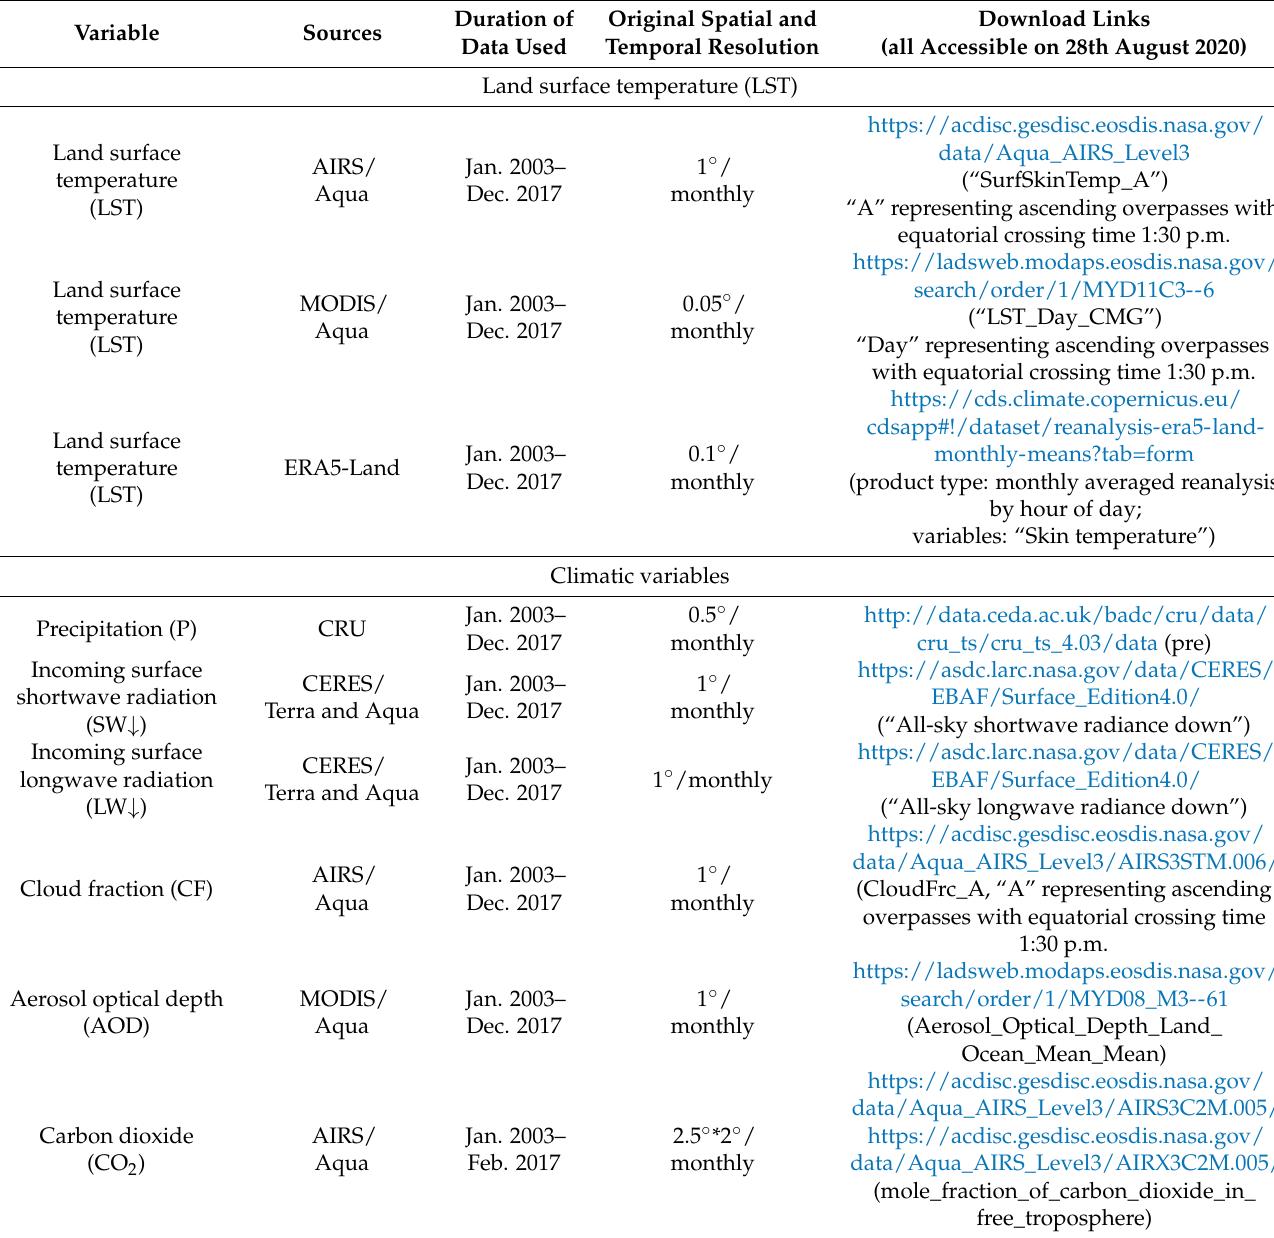
Table 1. Major characteristics of land surface temperature (LST), climatic variables, and land surface condition datasets used